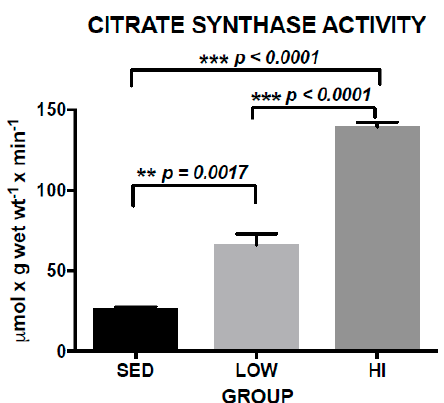
Figure 2. Soleus muscle citrate synthase activity in increased in a dose-dependent manner for sedentary (SED), low-intensity exercise-trained (LOW), and high-intensity exercise-trained (HI) Tg2576 mice. Values represent the mean ± s.e.m.